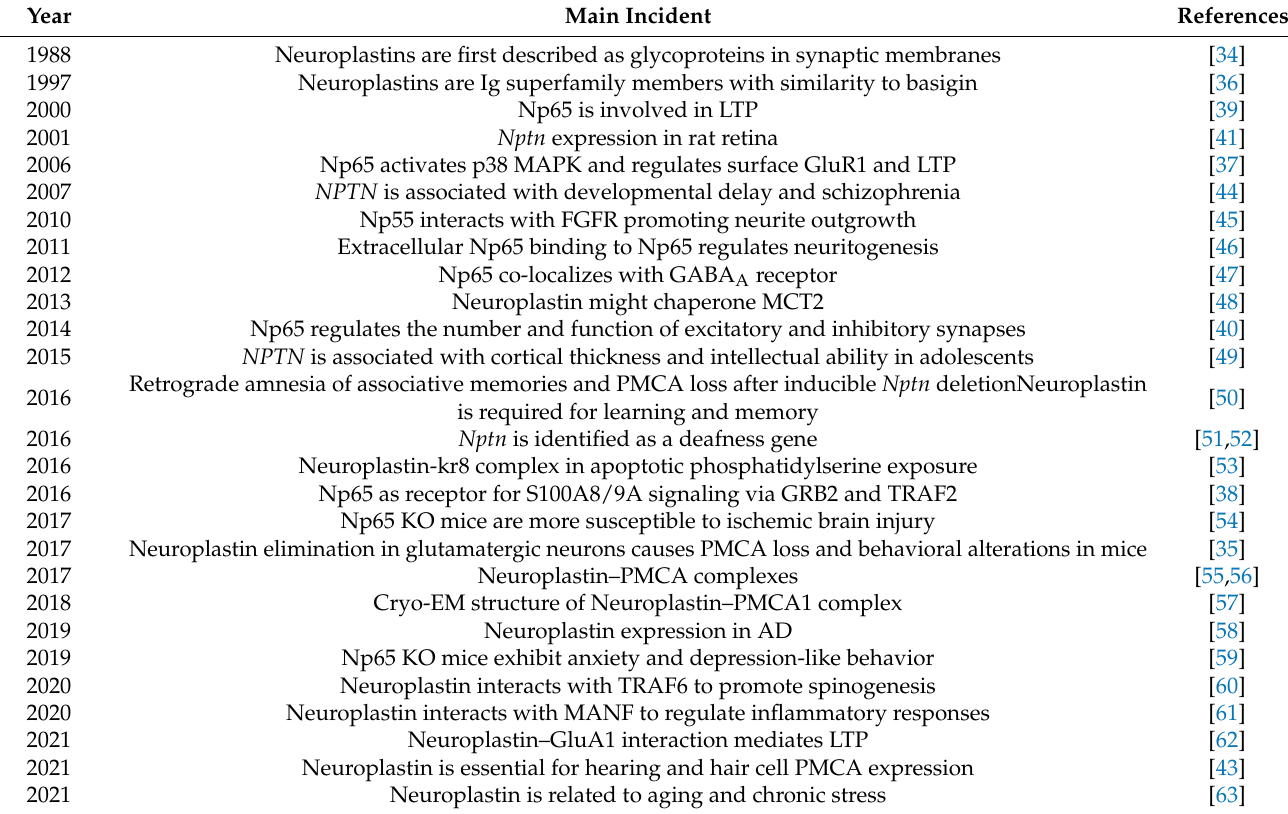
Table 1. History of discoveries in neuroplastin